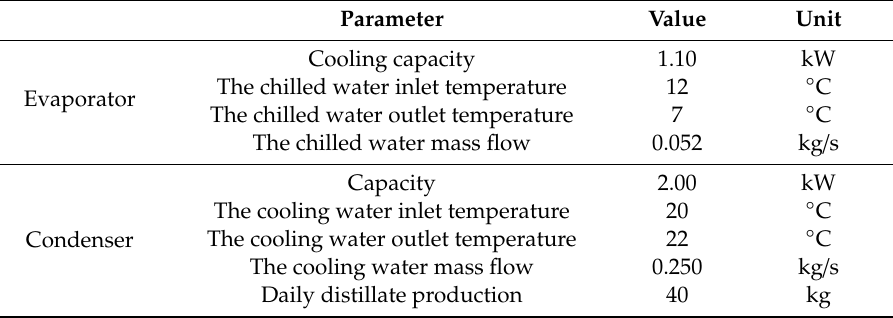
Table 1. The nominal main parameters of the adsorption